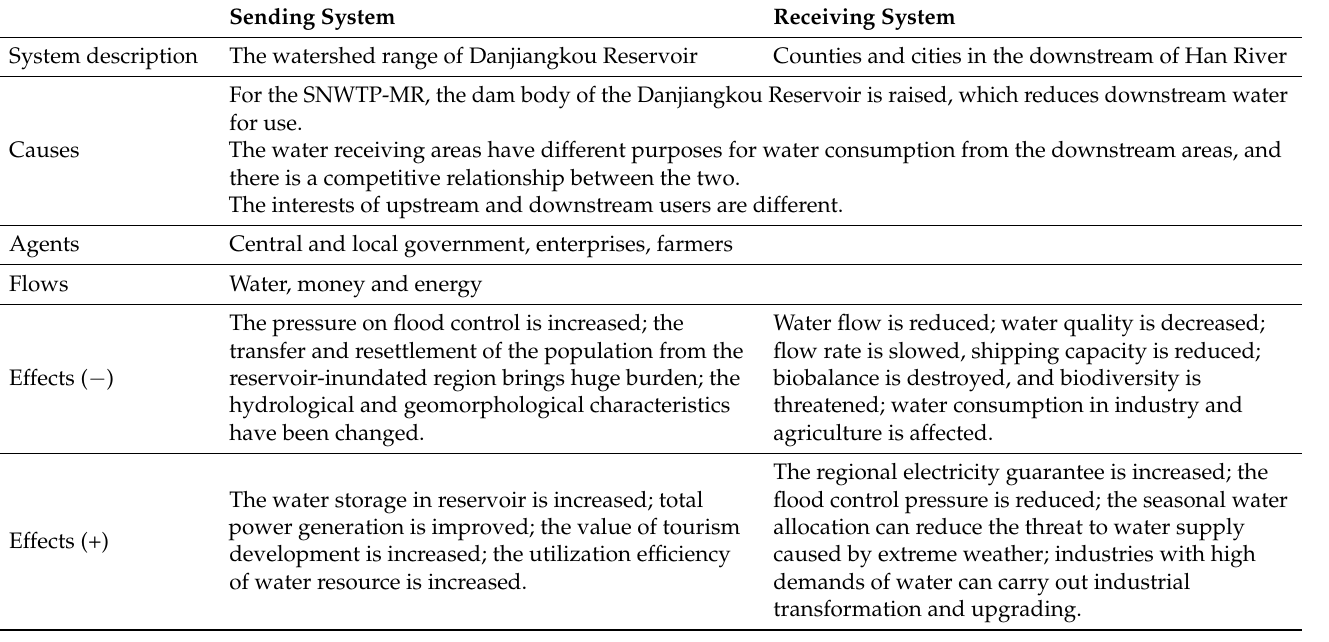
Table 2. Pericoupling of